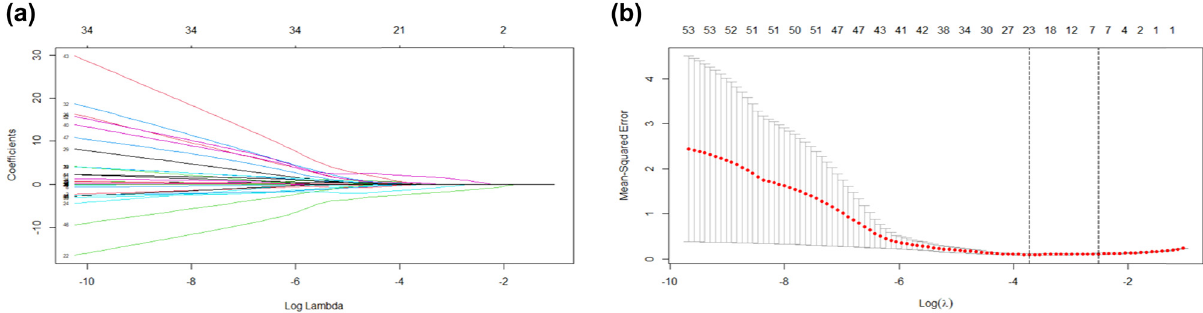
Figure 1: Predictive factors for patients with severe HFRS were selected by LASSO regression. ( a ) Fifty - four variables from the training cohort were included in the LASSO regression ( y - axis ) . The average number of predictors was shown at the top x - axis. ( b ) The parameter lambda ( λ ) was selected by using tenfold cross - validation based on the minimum standard in the LASSO model. The two vertical dashed lines represent the log ( λ ) of the minimum mean square error ( left dashed line ) and the log ( λ ) of the minimum distance standard error ( right dashed line ) . HFRS, hemorrhagic fever with renal syndrome; LASSO, least absolute shrinkage and selection operator; λ ,